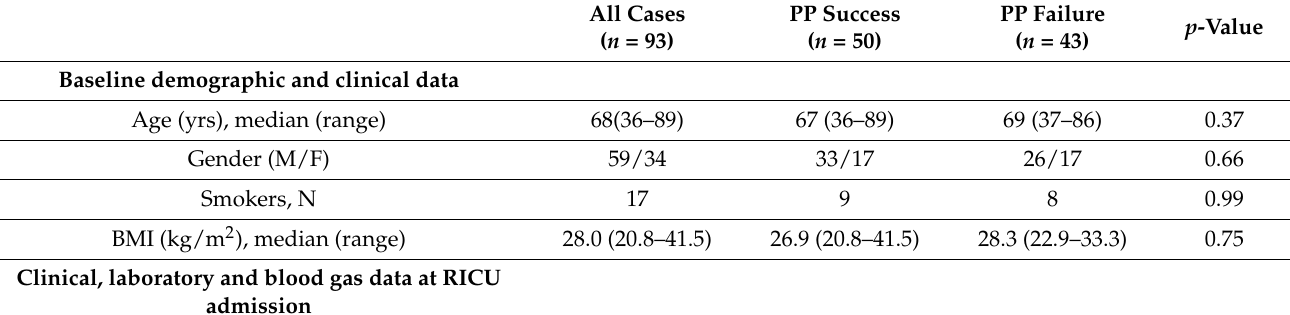
Table 1. Patients’ baseline demographic and clinical characteristics, and clinical and laboratory data at RICU admission. p -values refer to differences between Prone Positioning (PP) success and failure groups. (ACCI = Age-adjusted Charlson Comorbidity Index; BMI = Body Mass Index; CRP = C-Reactive Protein; PaO 2 /FiO 2 = arterial oxygen tension to inspired oxygen fraction ratio; SaO 2 = arterial oxygen saturation; SOFA = Sequential Organ Failure Assessment; WBC = White Blood